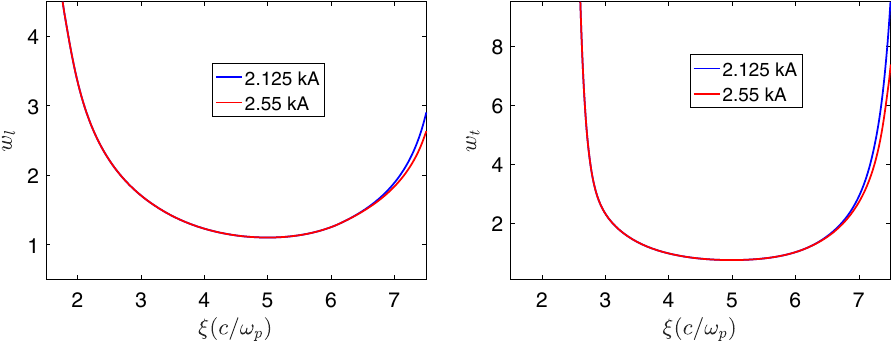
ˆ M = ˆ M w ¼ 8 ˜ M = ˜ M 12 11 and t 12 11 as functions of